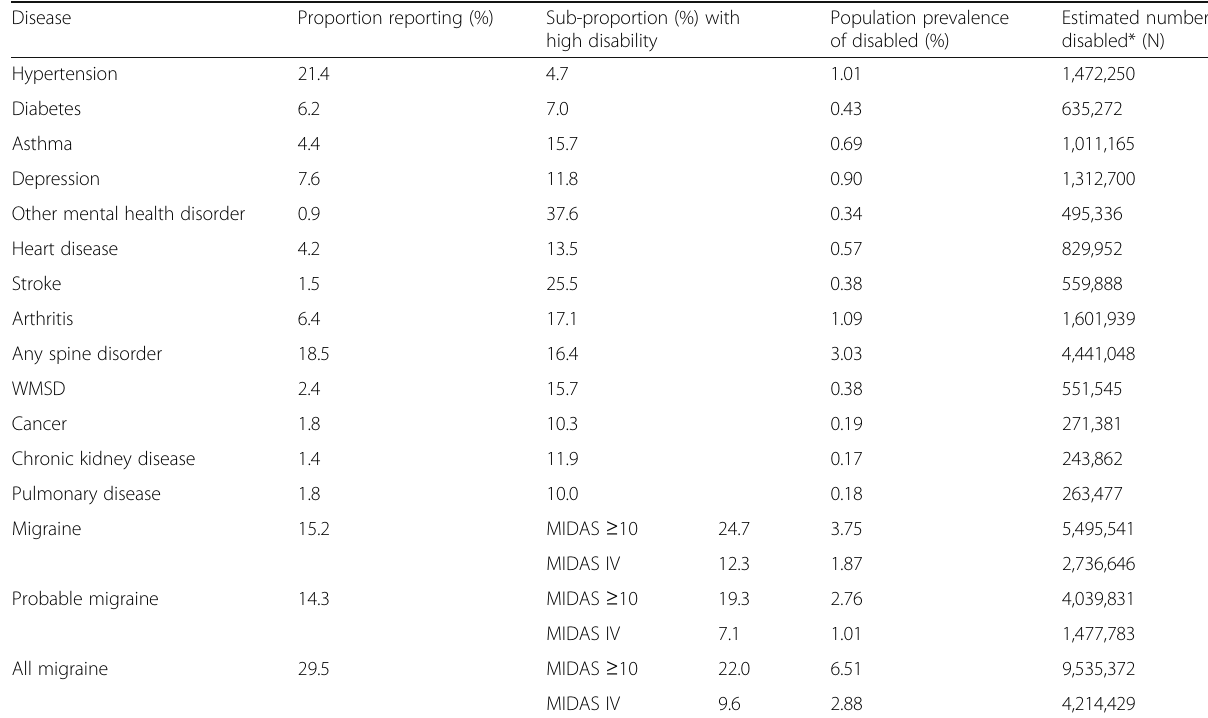
Table 2 Proportions (%) reporting chronic non-communicable diseases, sub-proportions (%) reporting high disability, and derived